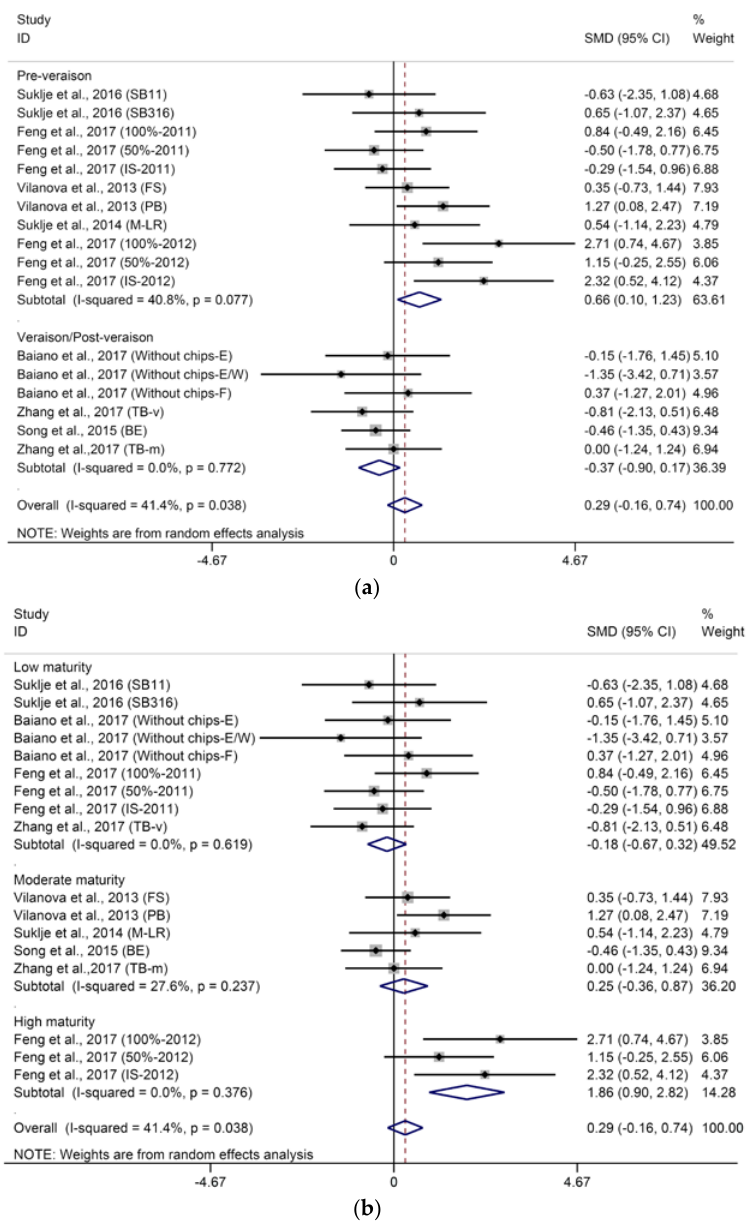
Figure 9. Meta-analysis for the effects of basal defoliation on ethyl octanoate in wine, of which trials were categorized based on the ( a ) timing of basal defoliation (pre-veraison and veraison/post-veraison), and ( b ) berry maturity level (low maturity of °Brix < 23, moderate maturity of 23 < °Brix < 25, high maturity of °Brix > 25).